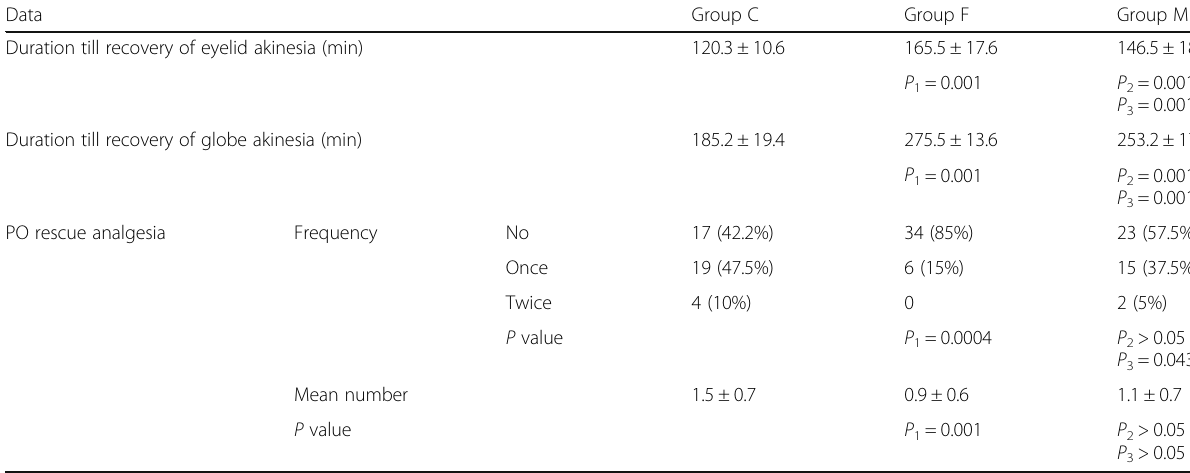
Table 4 Postoperative recovery data of studied patients categorized according to injected